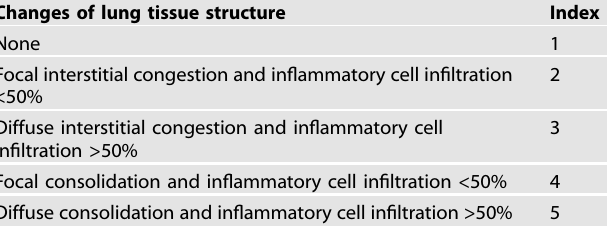
Table 1. Lung injury score parameters.